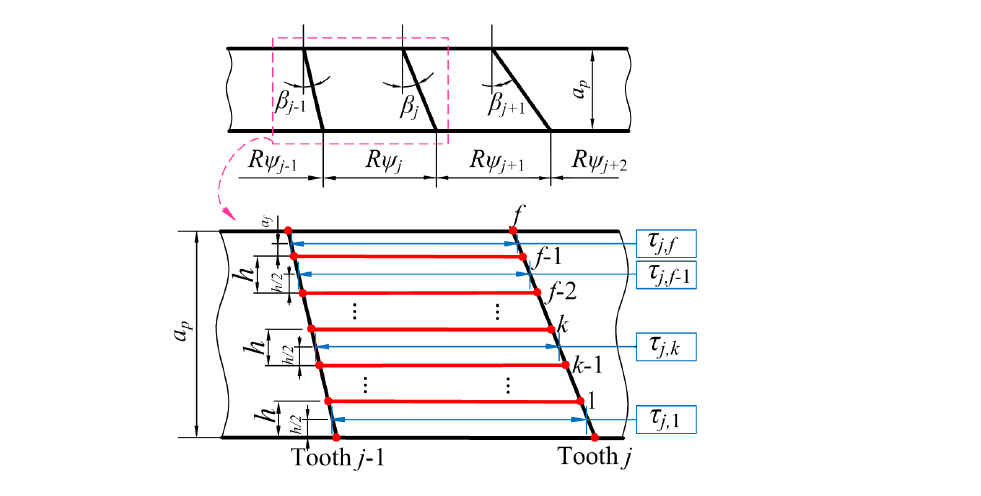
Figure 3. Schematic drawing of the relationship of the segmentation of the axial depth of cut and time delay.